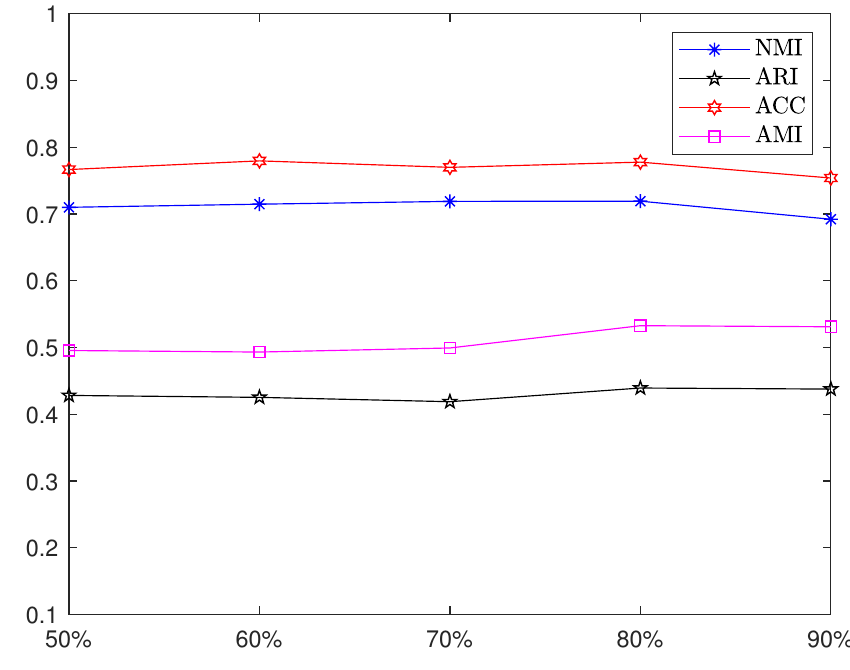
Figure 10. Results of Segmentation by 3WESP.